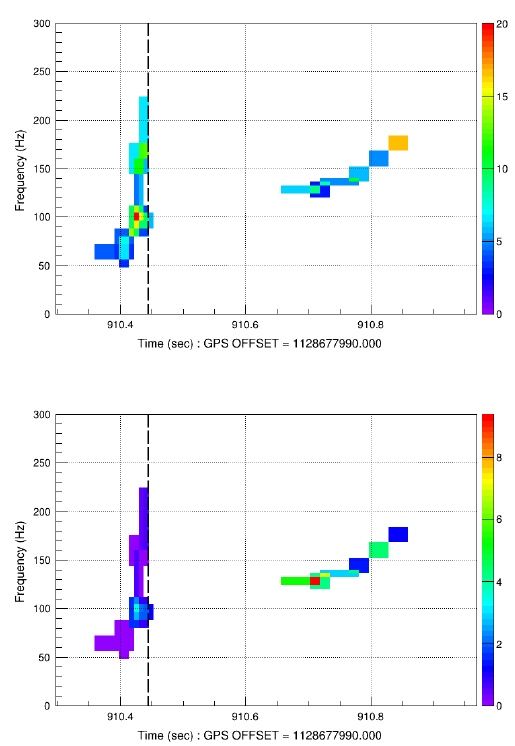
Figure 32. Reconstruction of cWB for the event GW151012 via color-coded time-frequency maps [25]. The upper plot shows the squared coherent network SNR and the plot bellow shows the normalized FIG. 3. cWB waveform reconstruction of GW151012, in form of color-coded time-frequency maps. The upper row shows residual noise energy. The residual plot is given after the reconstructed signal was subtracted from the the squared coherent network SNR, while the second row shows the normalized residual noise energy, E , estimated after the data. In this plots a secondary cluster occurring 200 ms after the merger (consistent with echo times N reconstructed signal is subtracted from the data. The first column ((a) and (d)) refers to the original reconstruction, with the predicted and seen by ADA, Equation (144)). The dashed vertical lines denote coalescence time for primary chirp on the left matching the CBC PE reconstruction and a secondary cluster occurring 200 ms after the merger; an GW151012 (the network has used the Livingston detector time as a ad hoc time veto covering the secondary cluster was used to produce our best estimate for GW151012 primary event shown in the second column ((b) and (e)); finally, the third column reports the independent reconstruction of the secondary cluster by vetoing the primary event. The dashed vertical lines denote the minR t for GW151012 (the network reconstruction uses L , coa the Livingston detector time as a reference) (a) (b) FIG. 4. Left panel: Mollweide projection of GW151012 primary event (blue contour lines) and the secondary event (green lines) sky reconstructions in equatorial coordinates (a). Right panel: time delay maximum a posteriori probability marginals between H and L in line-of-sight frame defined by H and L (b). Both figures have been produced using the code in [24].